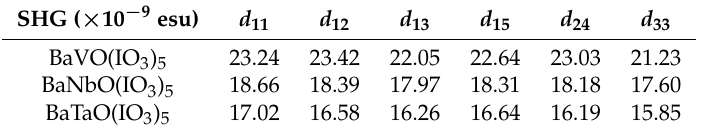
Table 2. The SHG tensor components of BaMO(IO 3 ) 5 (M = V, Nb and Ta) at 1064 nm.